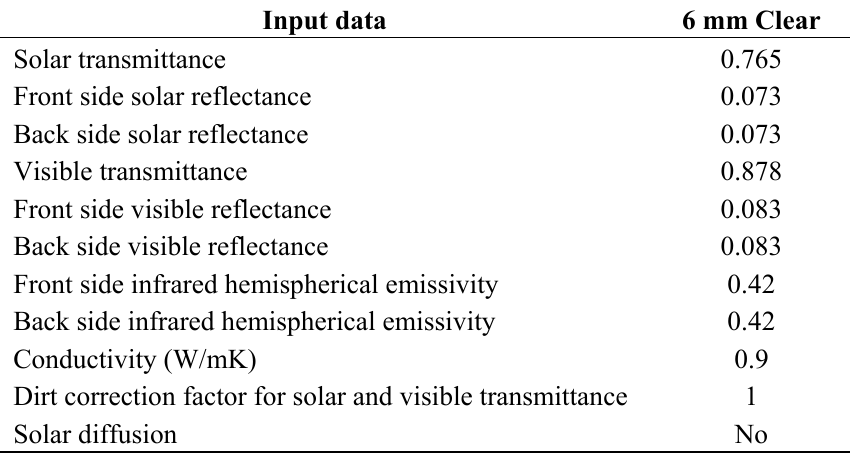
Table 1. Specifications of simulated